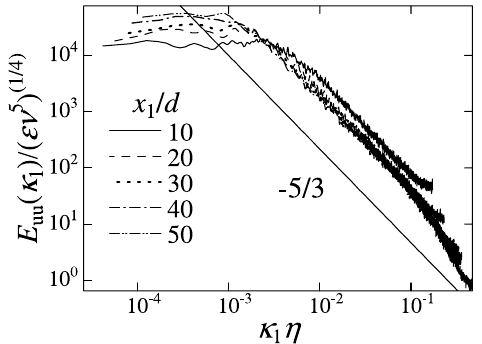
Fig. 17 Power spectra of fluctuating velocity at x 2 / b (cid:3) 1 . 0